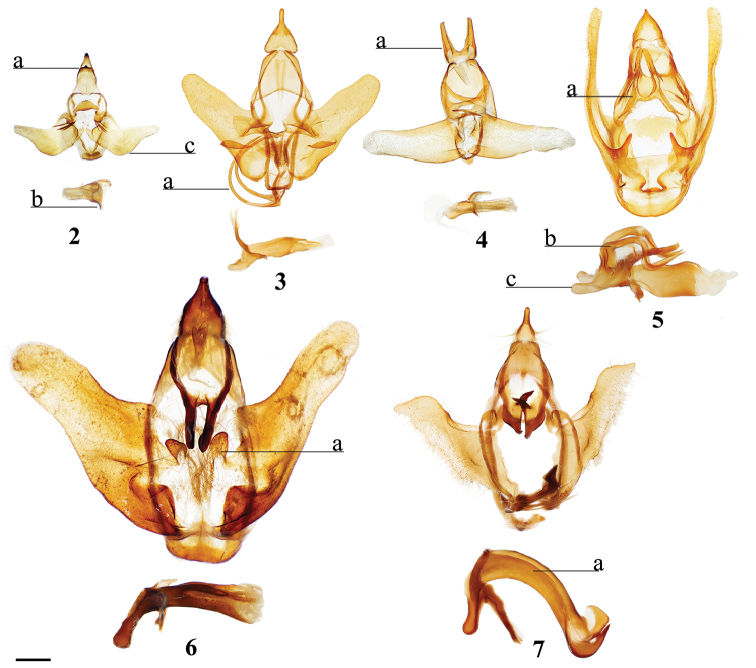
Ventral view of male genitalia of type species of genera belonging to Zaphantinae, incertae sedis, and Aurorianinae. Phallus/juxtal complex is figured below the genitalia in the lateral view. 2Zaphantainfantilis, St Laurent diss.: CPC 4 [reused with permission from St Laurent et al. (2018a), Systematic Entomology] (CRAS) 3Menevialantona, St Laurent diss.: 3-7-15:2 [reused with permission from St Laurent and Dombroskie (2016), ZooKeys] (CMNH) 4Tolypidacfamaryllis, St Laurent diss.: LEP53357 (MGCL) 5Cunicumaraanae holotype, St Laurent diss.: 3-14-16:6 [reused with permission from St Laurent (2016), ZooKeys] (CMNH) 6Roelofaolivia, St Laurent diss.: 8-17-17:2 (CRAS) 7Aurorianacolombiana holotype, St Laurent diss.: 11-3-15:1 [reused with permission from St Laurent and Mielke (2017), ZooKeys] (NHMUK). Scale bar: 1 mm.